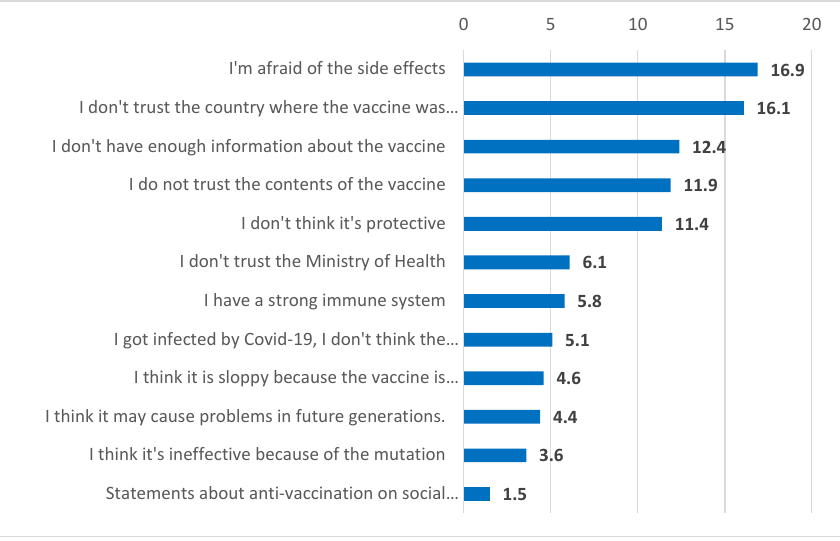
Figure 2. Participants’ r easons for not being vaccinated